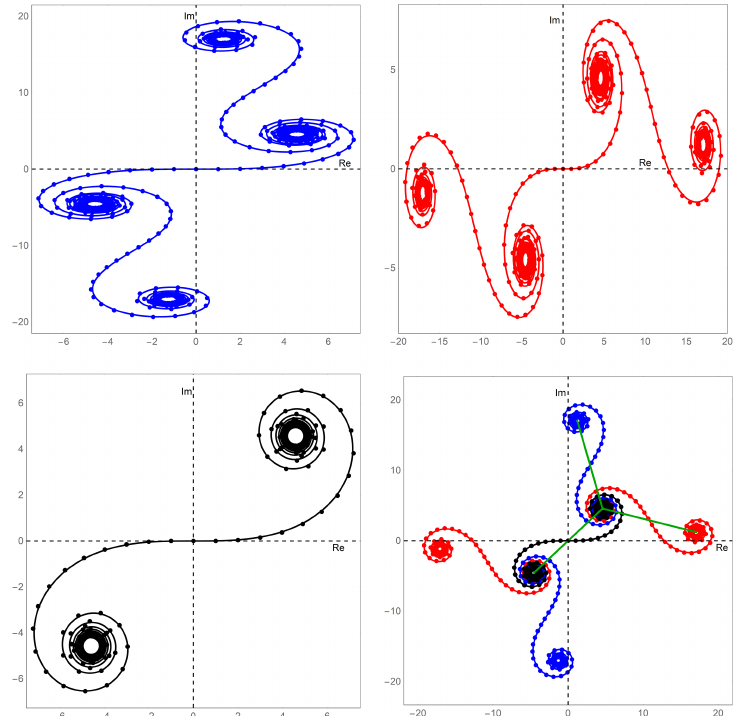
Figure 2. The sequence of partial summations for F 250,3 (top, left panel), F 251,3 (top, right panel), and F 252,3 (lower, left panel). These data sets represent the three basic shapes that occur when q n progresses, the shapes cycle through these q (in this case 3) canonical shapes (the space between adjacent datum decreases as n increase). Note there are three spirals present in the top two graphs. This is a manifestation of a general characteristic that there are q Cornu spirals. The exception seen in the lower left graph is also a general characteristic. In the case shown, q = 3 evenly divides n = 252. The result brings the data set into the F n ,1 class. If q is prime, this will happen only once. If q is composite, then there will be several values which divide into n . Finally, in all cases, inversion symmetry is preserved as must be the case. The lower right panel shows the members of this canonical family superimposed on one another. There is a three-fold local quasi-symmetry around the primary spiral centers (see text for details). The green trifold is set to guide the eye. Formula for the isometry of the trifoil from the origin is given in the